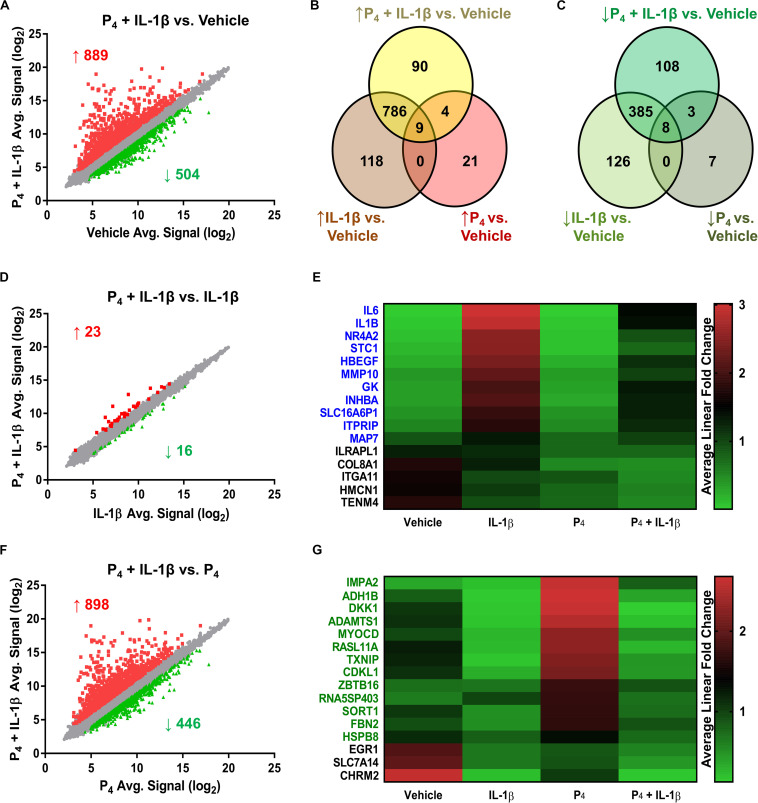
Differential gene expression in cervical stromal fibroblasts stimulated with either IL-1β (0.2 ng/ml), P4 (10–7 M) or both for 4 h followed by microarray analysis and data normalization. (A) shows the scatter plot and Venn diagrams comparing upregulated (B) and downregulated transcripts (C) in response to IL-1β +P4 or vehicle. (D) Scatter plot and (E) heat map of differentially expressed genes in response to IL-1β or IL-1β + P4. (F) Scatter plot and (G) heat map of differentially expressed genes in response to P4 or IL-1β +P4.